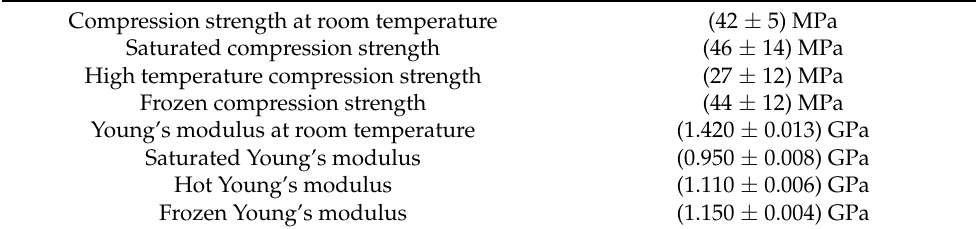
Table 1. Values of average compression strengths and average Young